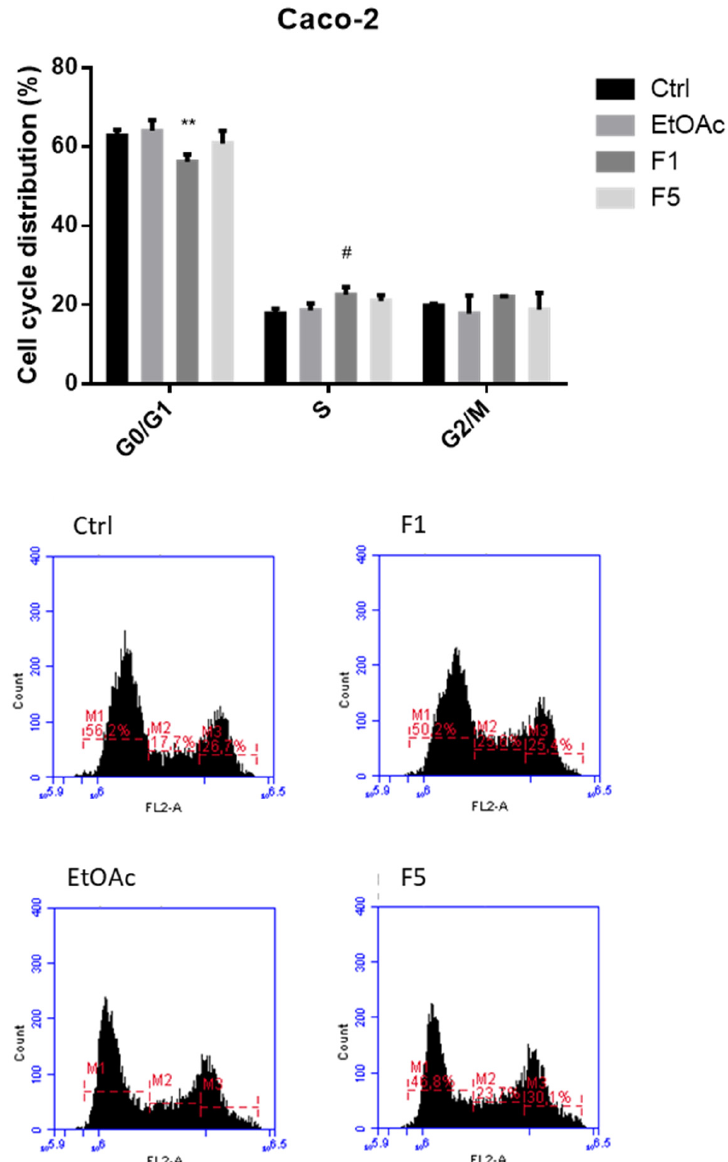
Figure 2. Effect of F. vesiculosus samples on the cell cycle distribution of Caco-2 cells after 48 h. Data are expressed as percentage of propidium iodide positive (PI + ) cells and are presented as the mean ± SEM of at least three independent experiments (* p < 0.05, ** p < 0.01, when compared with control; the symbols * and # were used to express statistical significance within G0/G1 and S, re- spectively).